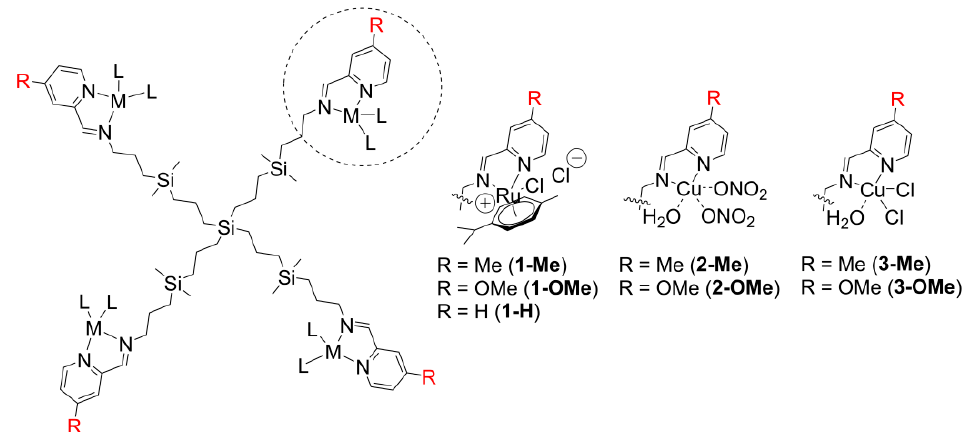
Figure 1. Chemical representation of the Ru(II) and Cu(II) carbosilane metallodendrimers, bearing R-substituents in meta position to the imine moiety.